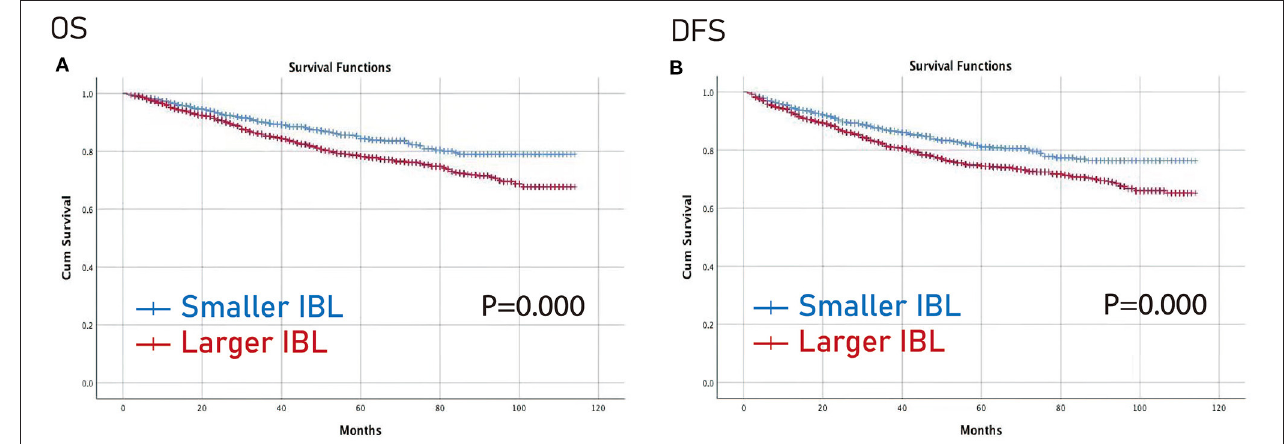
FIGURE 2 | Prognosis of IBL on patients with CRC. (A) OS; (B) DFS. OS, overall survival; DFS, disease-free survival; IBL, intraoperative blood loss; CRC, colorectal cancer.